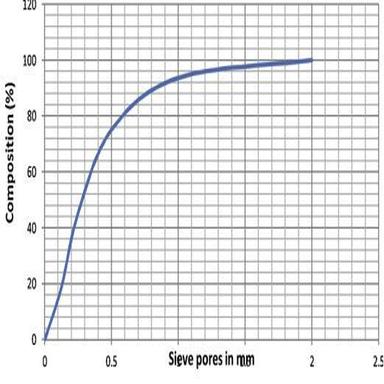
Granulometric composition of the composite sample.